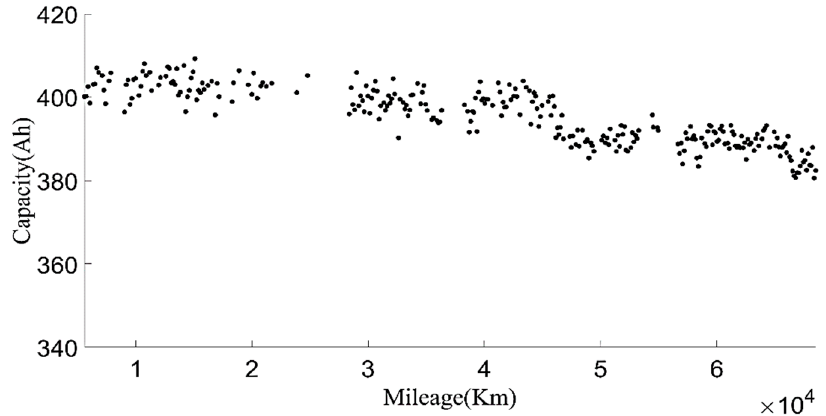
Figure 6. The relationship between the current capacity and the mileage.